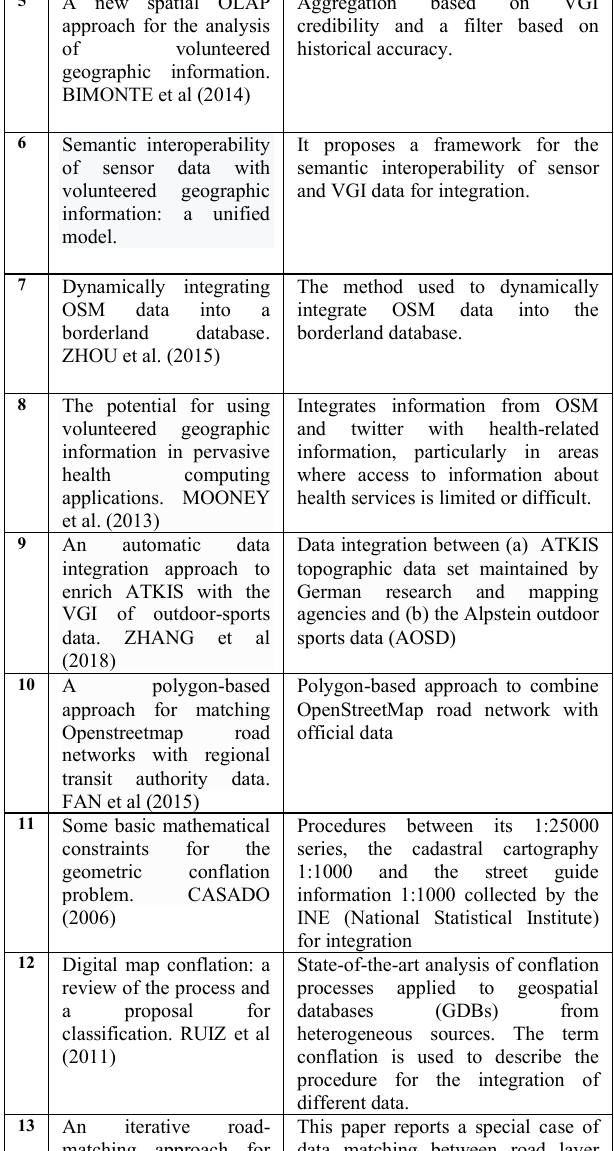
Figure 5: The use of VGI in the European NMAs (Olteanu-Raimond, et al., 2017)